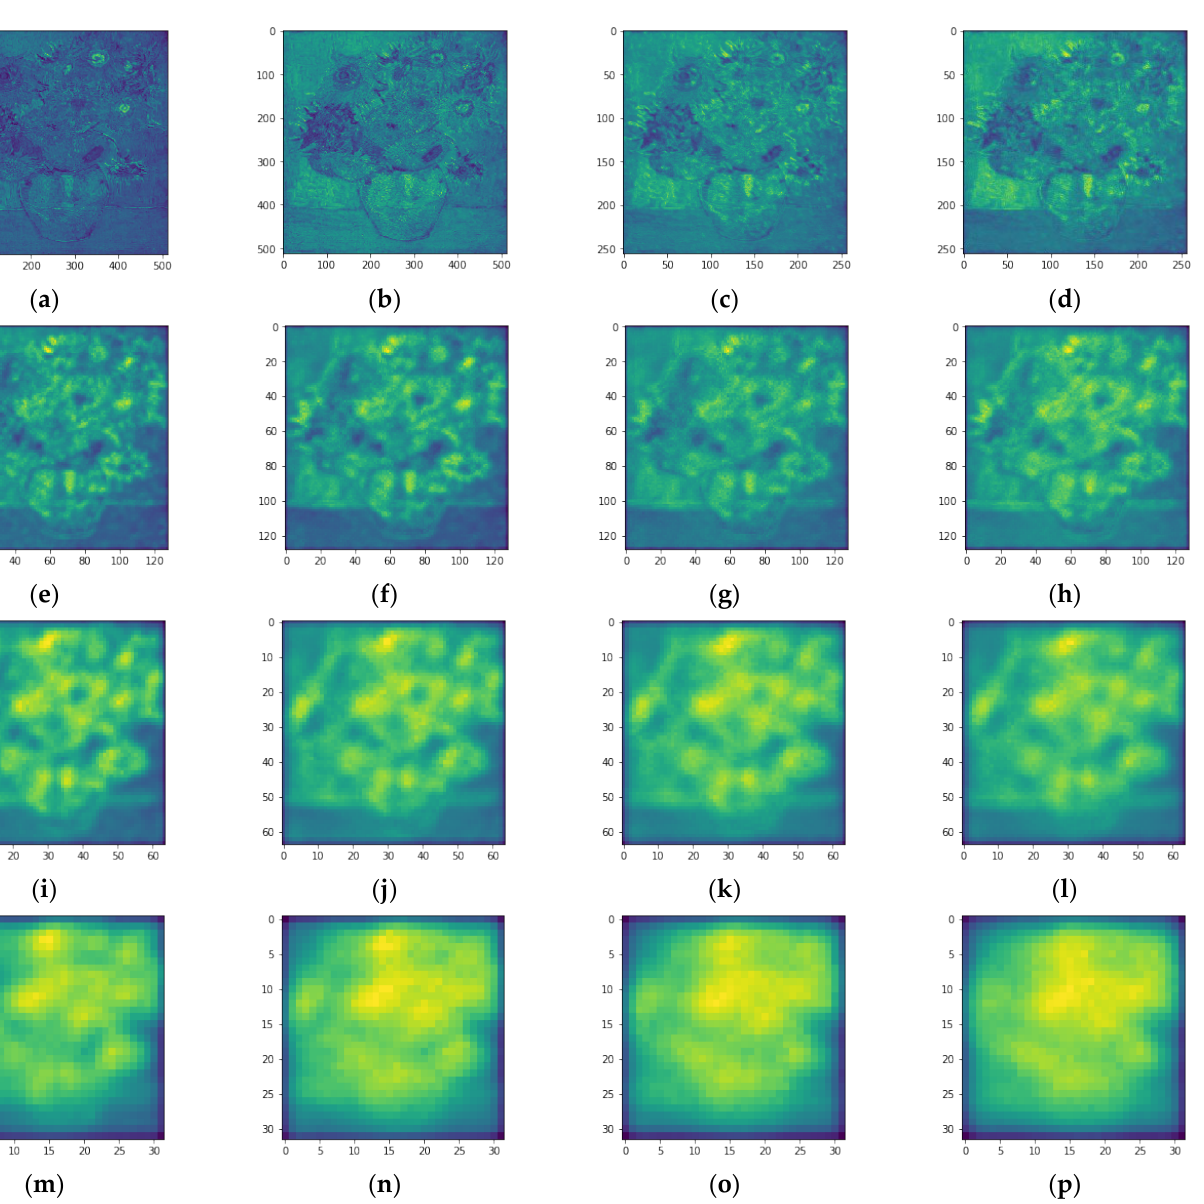
Figure 11. The fusion feature maps of each convolutional layer. ( a , b ) shows the fusion feature maps in the first major convolutional layer. ( c , d ) shows the fusion feature maps in the second major convolutional layer. ( e – h ) is the fusion feature maps of the third major convolutional layer. ( i – l ) is the fusion feature maps of the fourth major convolutional layer. ( m – p ) is the fusion feature maps of the fifth major convolutional layer.